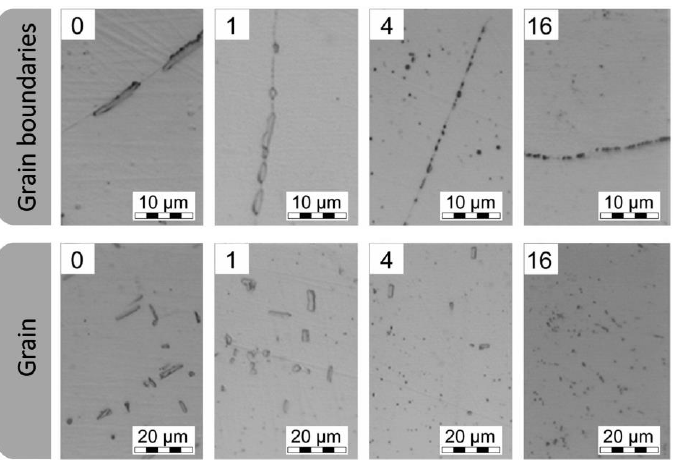
Figure 5. Optical micrographs of vanadium carbides evolution after isothermal treatments at 1100 °C for different times and with water quenching in samples from the prismatic ingot. The treatment times are 0 (as-cast), 1, 4, and 16 h (time indicated in the upper left corners of each micrograph).